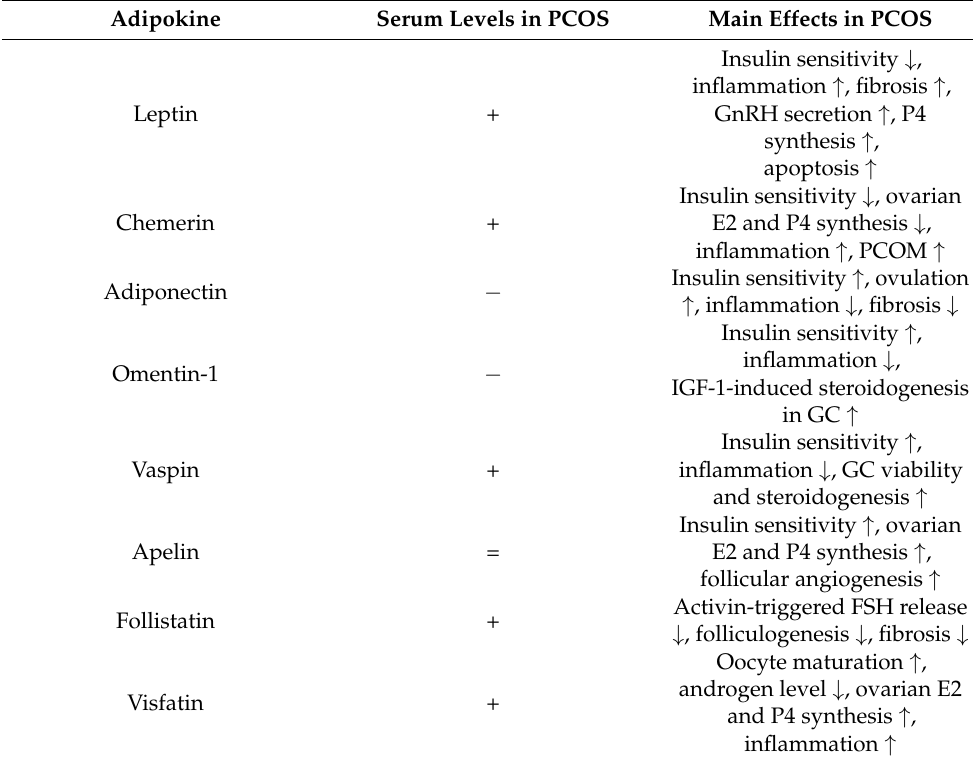
Table 2. Adipokines and their main effects in women with